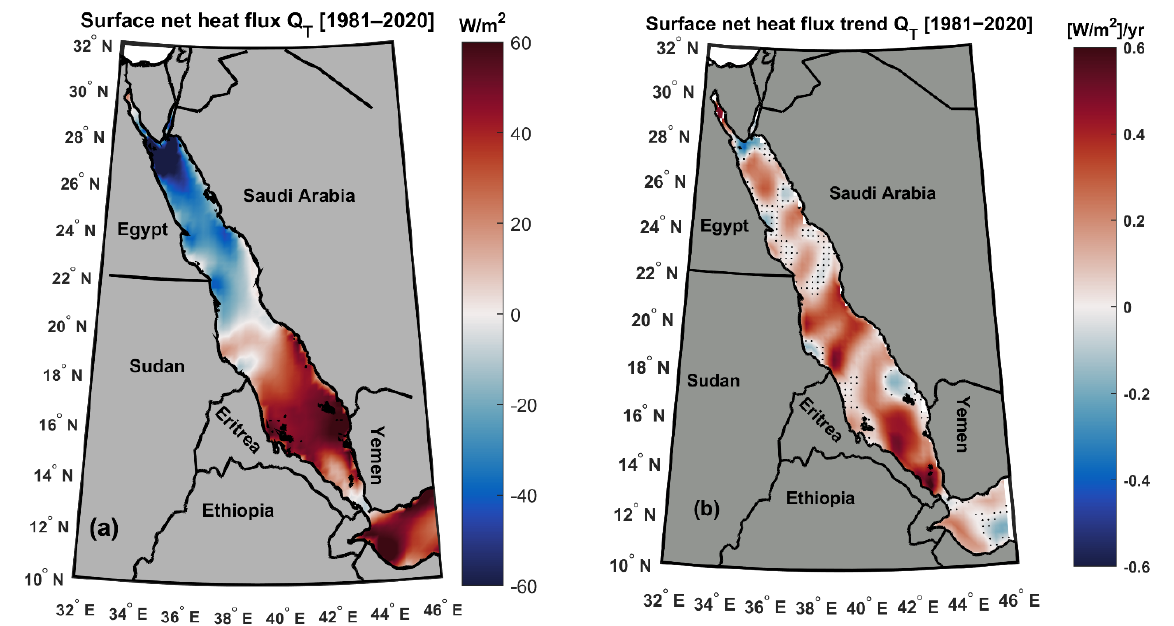
Figure 4. ( a ) Spatial distribution of the mean surface net heat flux (W/m 2 ) over the Red Sea from 1981 to 2020; ( b ) mean trend ((W/m 2 )/yr) for the Red Sea from 1981 to 2020, where the black dots indicate the change is not significantly different ( p > 0.05).